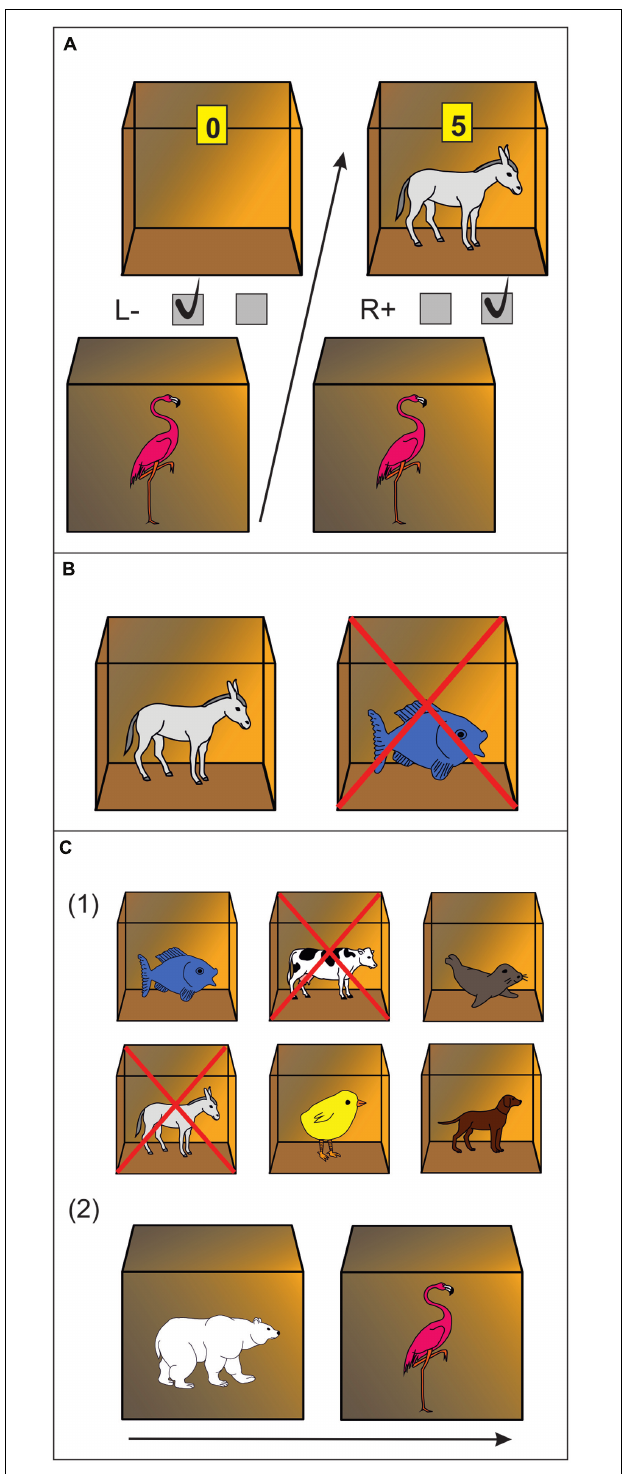
FIGURE 1 | Experimental paradigm. (A) Discrimination training phase. In this example, a flamingo stimulus outside of a box indicates that pressing the right key will be rewarded with a donkey and points inside of the box. Pressing the left key will not be rewarded (empty box is revealed). (B) Outcome-